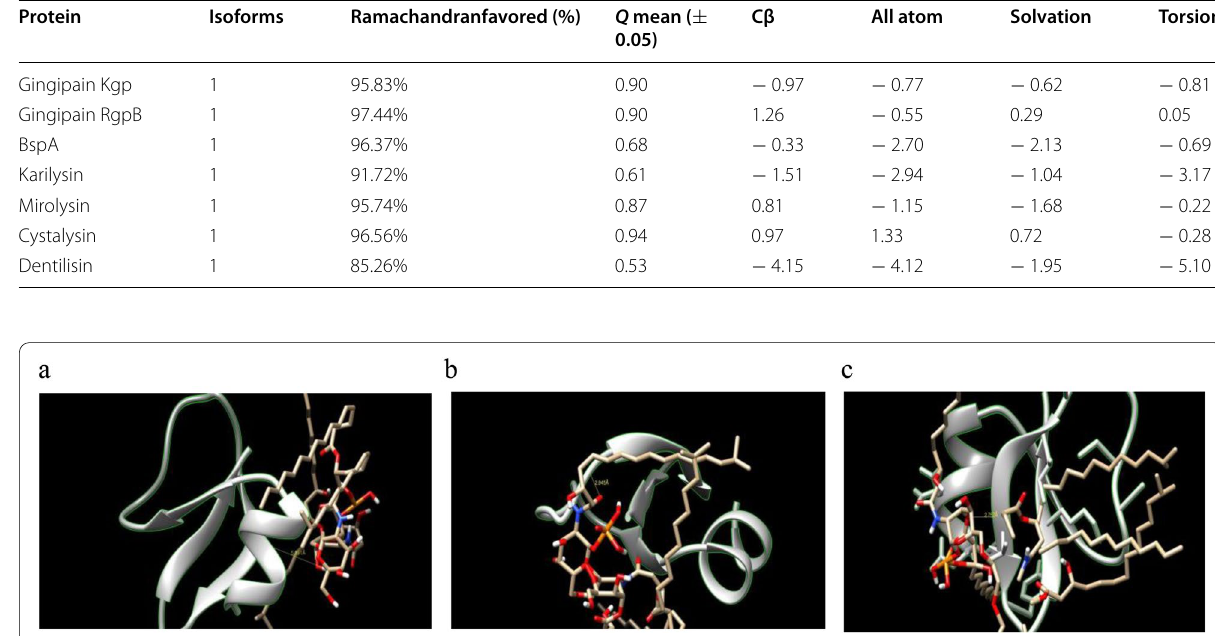
Fig. 7 Interaction of β-defensin 1 with LPS of P. gingivalis : a With LPS 1435 , b LPS 1449 , and c LPS 1690